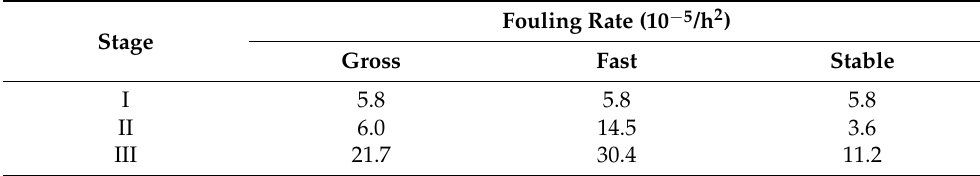
Table 2. Different fouling rates in each